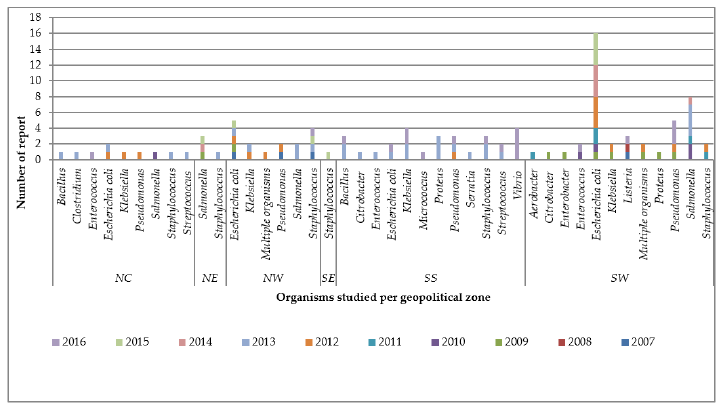
Figure 2. Number of reports yearly per organism for the geopolitical zones of Nigeria. NC = North central, NE = North east, NW = North West, SE = South East, SS = South South, SW = South West.